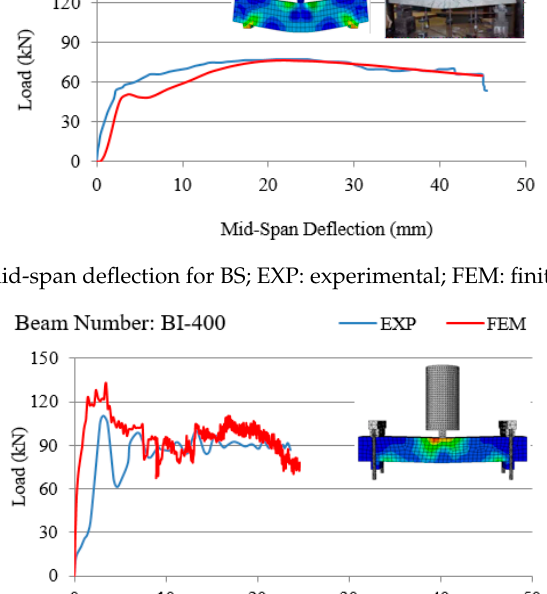
Figure 7. Load vs. mid-span deflection for BI-400 .